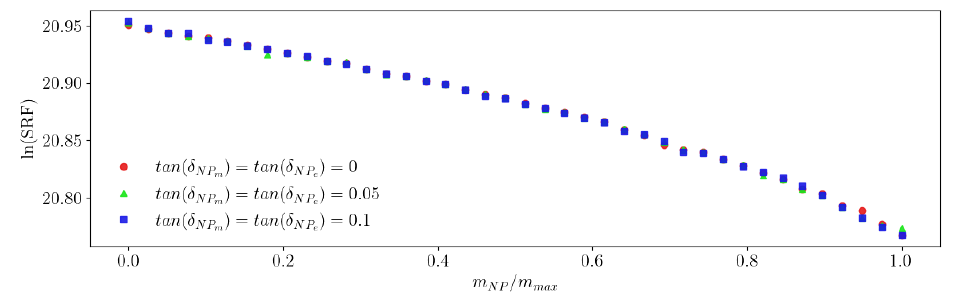
Figure 8. Dependence of the ln ( SRF ) on the ratio m NP / m max for different lossy